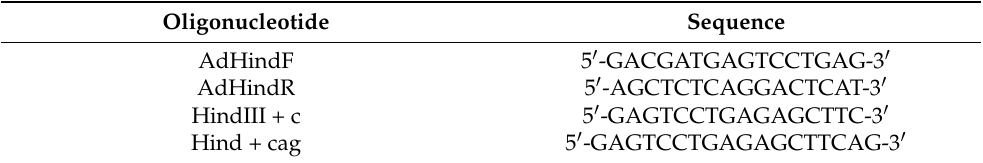
Table 1. Oligonucleotides used for SAFLP reactions, modified from Vos et al., 1995